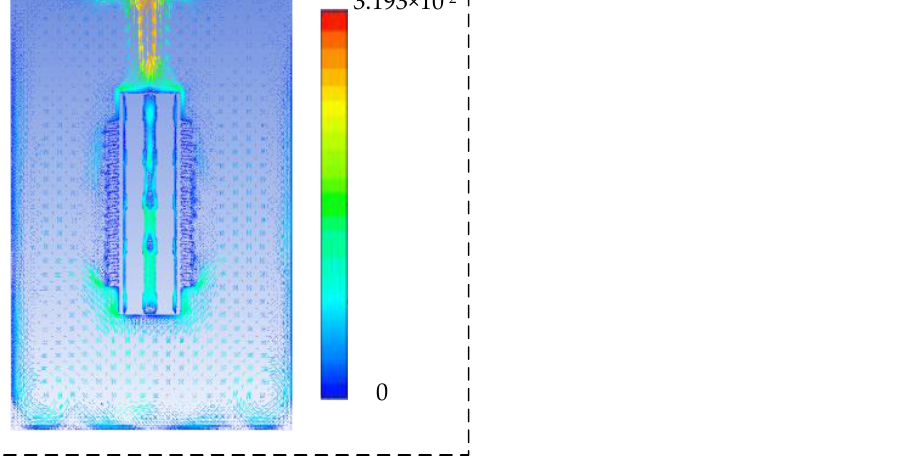
Figure 8. The flow line diagram of the SF 6 fluid in the multi-column arrester under monopole earth loop operation mode.